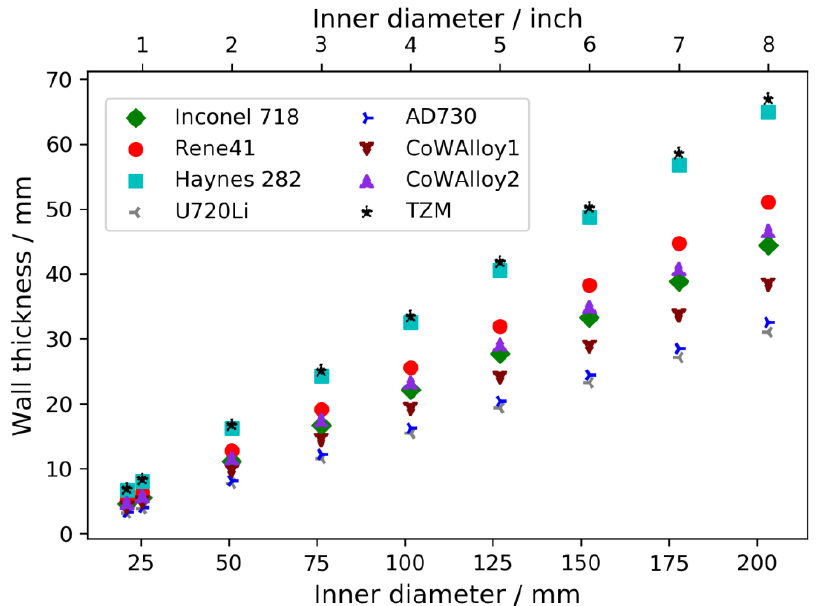
Figure 8. Wall thickness for a maximum operating pressure of 120 MPa estimated using Equation (1), with R p 0.2 of the different alloys at 650 ◦ C and a safety factor of 1.5 (i.e., p = 180 MPa). For better readability of the data for the remaining alloys, the values for Inconel 625 were excluded from the plot because the low mechanical strength would cause dissimilarly large wall thicknesses. The lowest inner diameter represents the experimentally studied geometry with 21 mm inner diameter.